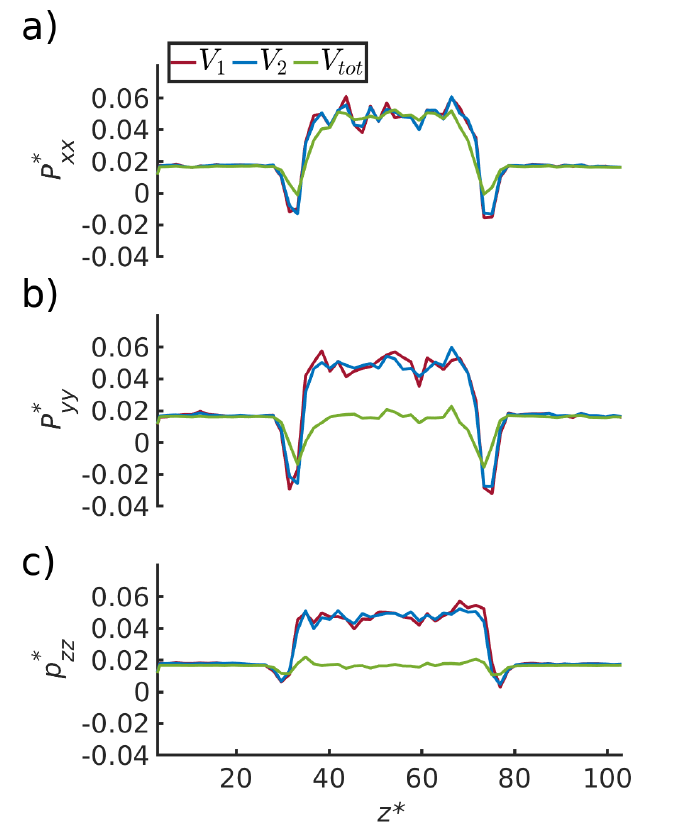
Figure 5. Pressure components ( a ) P xx , ( b ) P yy and ( c ) P zz , as a function of the z - direction for three regions defined using the growing-core methodology. The liquid droplet is in the center of the box, from z = 30 σ 0 to z = 75 σ 0 . There is a vapor phase on both sides of the liquid